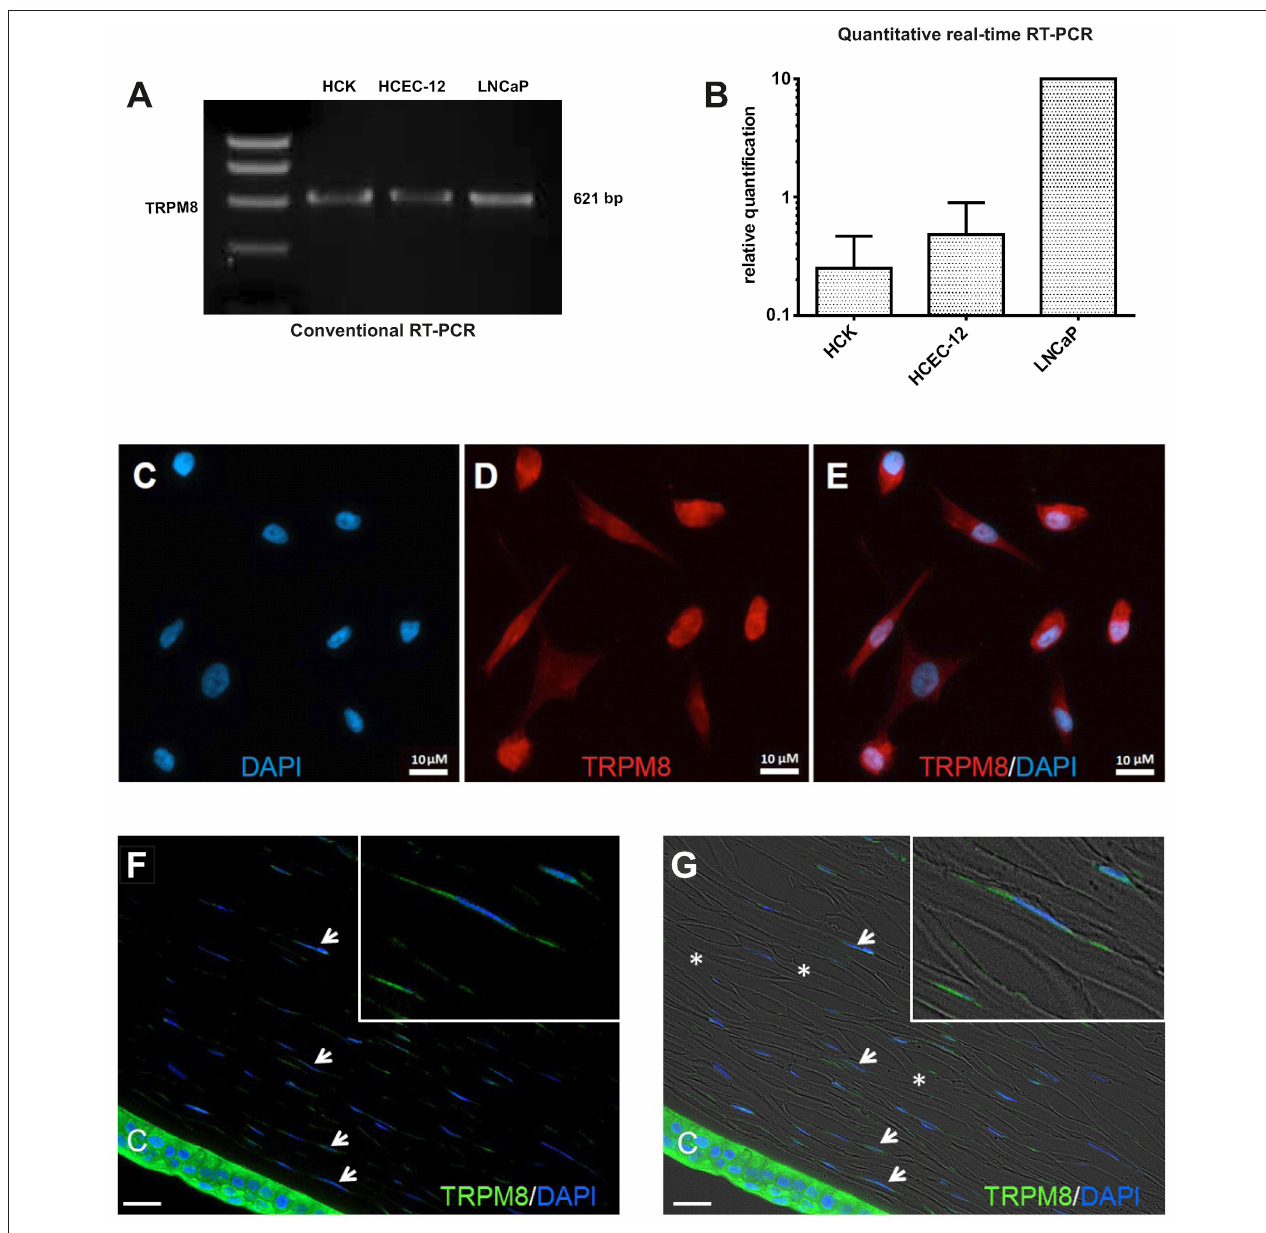
FIGURE 6 | TRPM8 gene and protein expression in HCK. (A) Conventional RT-PCR indicates mRNA signal of TRPM8 amplicon (621-bp) in human corneal keratocytes (HCK), human corneal endothelial cells (HCEC-12) and human prostate cancer cells (LNCaP) as a positive control. (B) Quantitative real-time RT-PCR analysis. The data were normalized to LNCaP with the positive mRNA signal. GAPDH was used as a housekeeping gene for normalization. Data are the mean ± SEM of 3 independent triplicate experiments. (C–E) Immunocytochemistry documents subcellular TRPM8 localization. (C) Nuclear staining with DAPI (blue). (D) TRPM8 positive cells (red). (E) merged. (F,G) IF analyses identify TRPM8 expression in human cadaver corneal cross sections. Stromal keratocytes (arrows) and corneal epithelial cells (CEC) clearly show a subcellular IF signal (green). Cell nuclei were counterstained with DAPI (blue). The overlay of fluorescence with bright field picture demonstrate parallel arrangement of the collagen fibrils (*) and stromal keratocytes interspersed between the lamellae. Inlays show higher magnification of stromal keratocytes. Pictures are representative of IF results obtained from five cadaver corneas ( n = 5).